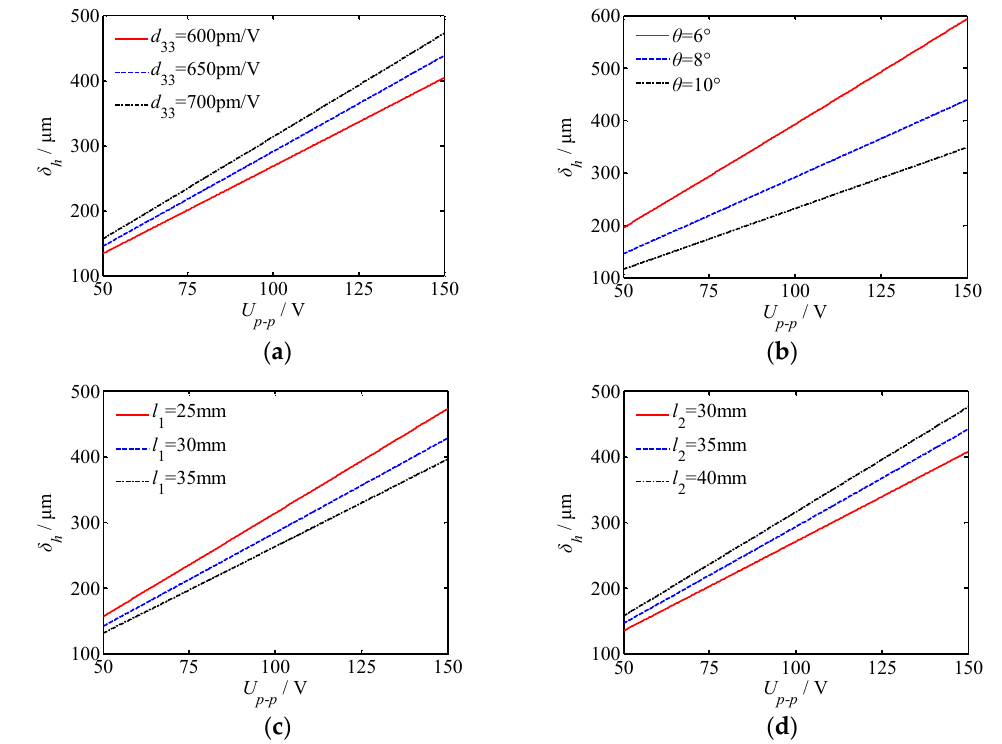
Figure 11. The influence of parameters on total harmonic displacement. ( a ) d 33 changes; ( b ) θ changes; ( c ) l 1 changes; ( d ) l 2 changes.